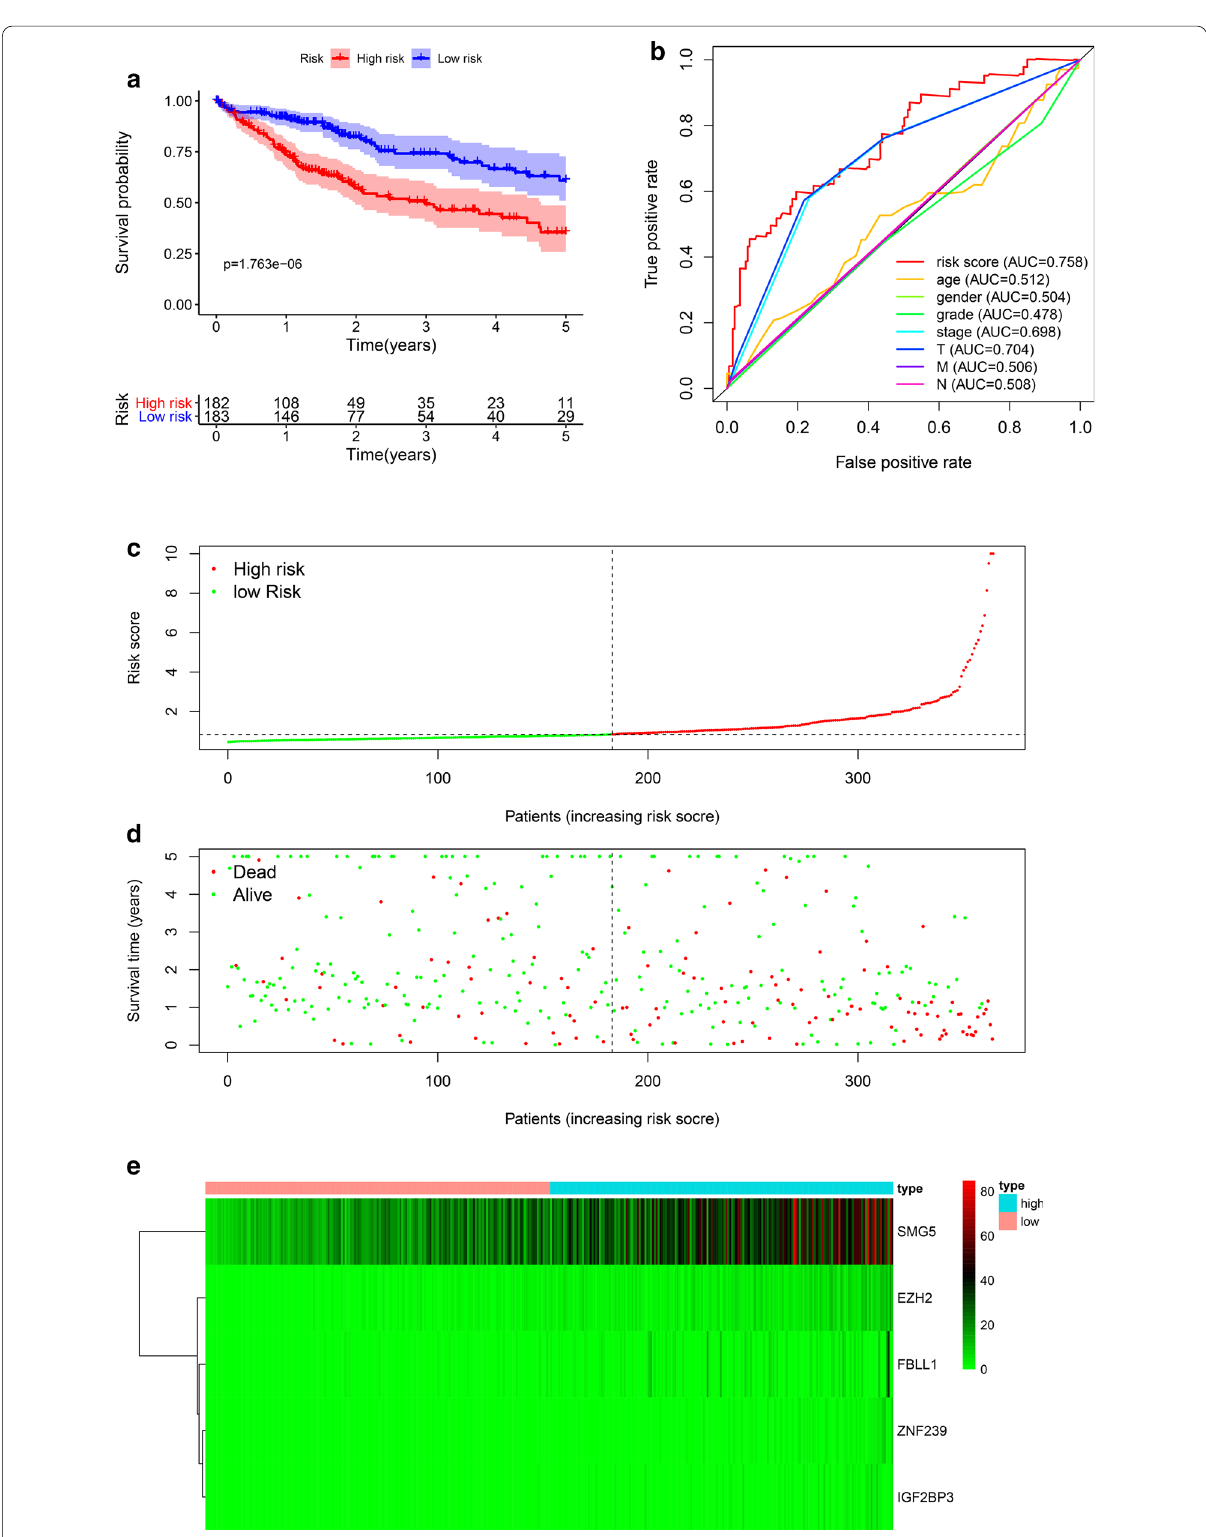
Fig. 5 Gene signature of hepatocellular carcinoma patients in TCGA cohort. a Kaplan–Meier curve of high-risk and low-risk HCC patients. b ROC curve of OS-related gene signature. c Risk score distribution of HCC patients with different risks. d Scatterplots of HCC patients with different survival status. e Heatmap of expression of 5 RBPs in HCC